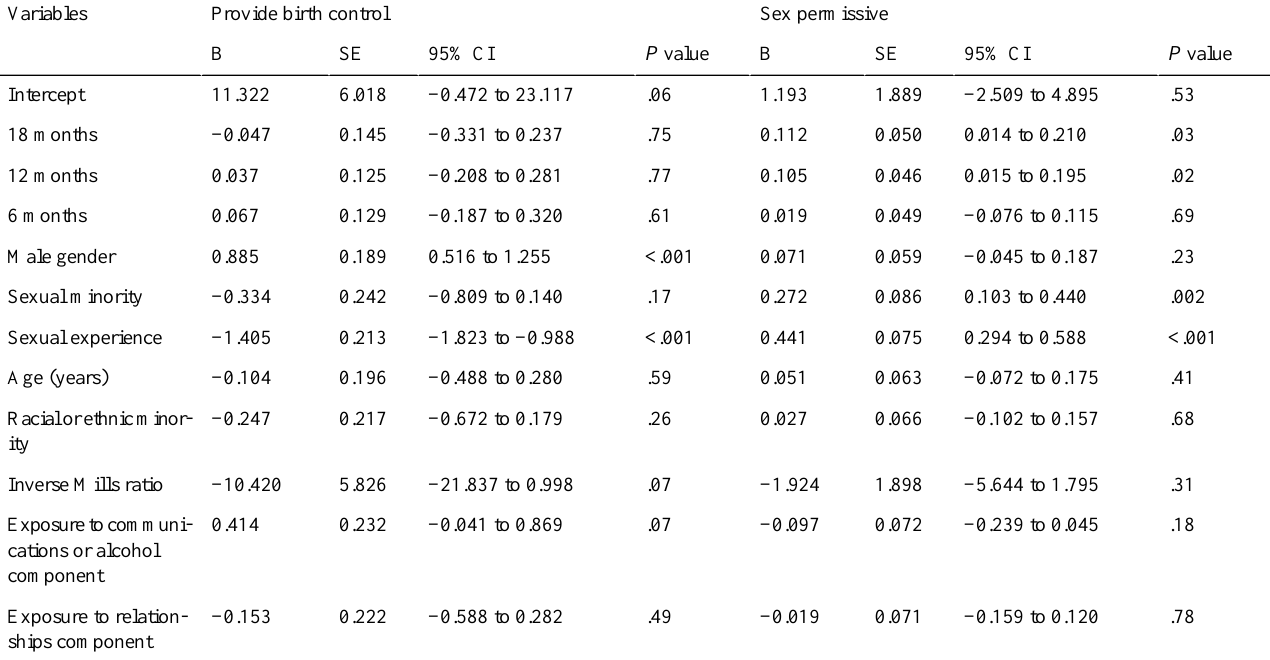
Table 4. Results from generalized estimating equations: main effects of intervention exposure on adolescent report of sexual communication: positive communication (T0: n=411; T1: n=325; T2: n=311; T3: n=309).